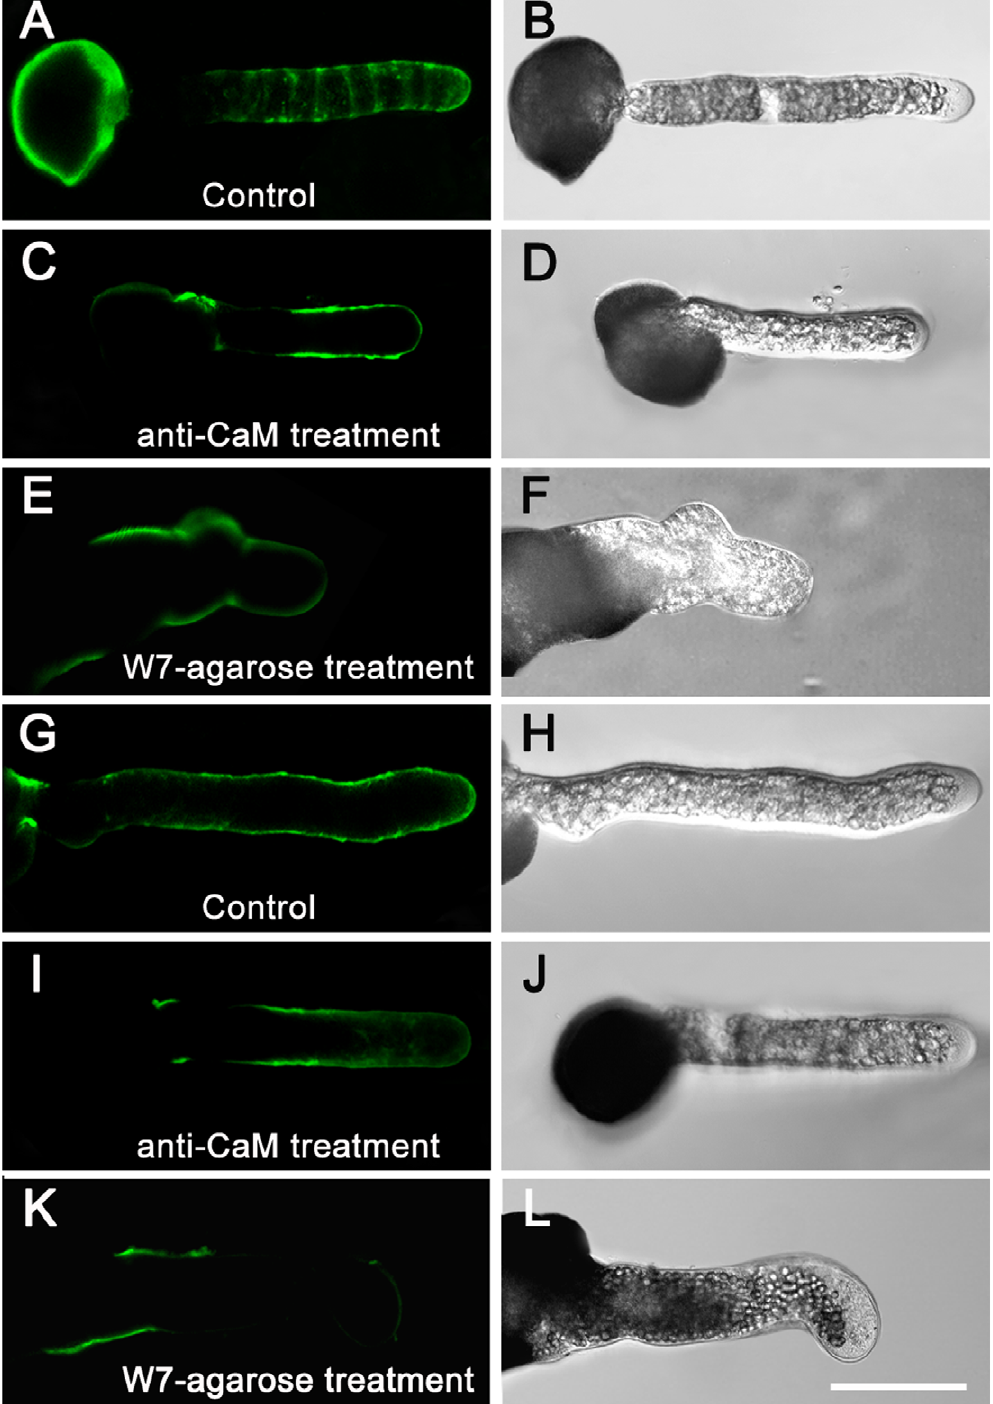
Figure 6. Variations in distribution and deposition of JIM5- and JIM7-reactive pectins after anti-CaM and W7-agarose treatments. Immunolabeling of pectins in pollen tube wall was carried out following the procedures described by Derksen (1999) with slight modifications. Pollen tubes were fixed and incubated in JIM5 and JIM7 as the primary antibody, and then incubated with FITC-labeled sheep anti-rat IgG as the secondary antibody. Samples were mounted and photographed under LSCM (excitation, 488 nm; emission, 522 nm). Controls were prepared by omitting the primary antibody. Samples consisted of 50 m L cultured pollen tubes (1 mg/mL at beginning of pollen culture) for immunofluorescence labeling experiments (repeated for three cultured sample bulks), of which five to nine pollen tubes were used for image collection and subsequent data analysis. A–B, JIM5-reactive pectins deposited in characteristic ring-like pattern along tube shank in control pollen tubes. C–D, JIM5-reactive pectins showed enhanced deposition along tube shank but slightly decreased deposition in apex, and characteristic ring-like deposition was no longer detected after anti-CaM application. E–F, W7-agarose application abolished characteristic ring-like deposition of JIM5-reactive pectins. G–H, JIM7- reactive pectins distributed almost uniformly along whole length of control pollen tubes. I–J, JIM7-reactive pectins displayed uneven distribution